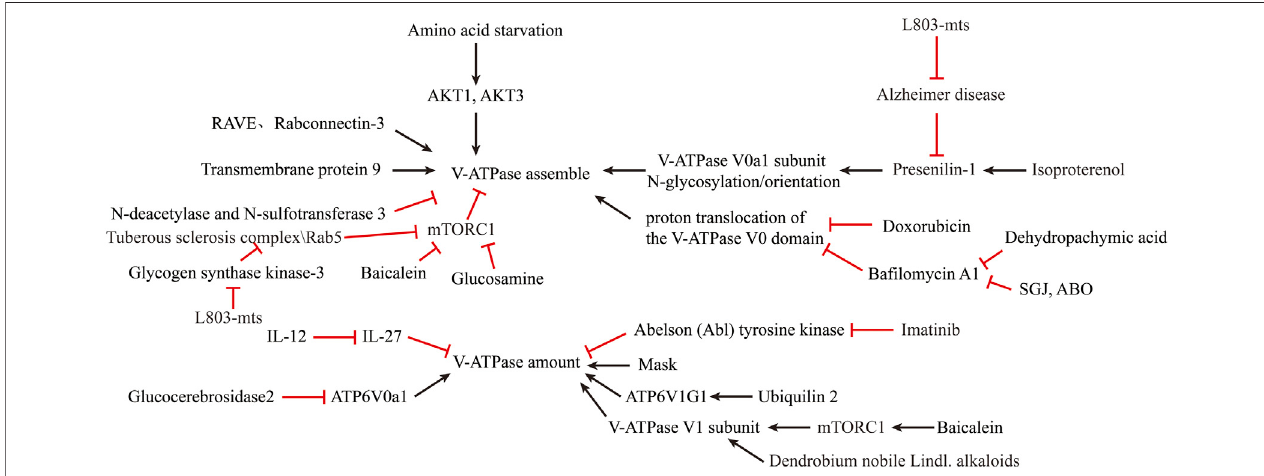
FIGURE 3 | Reversal of lysosomal acidi fi cation in in-vitro ampli fi ed senescent MSCs by regulating V-ATPase activity.